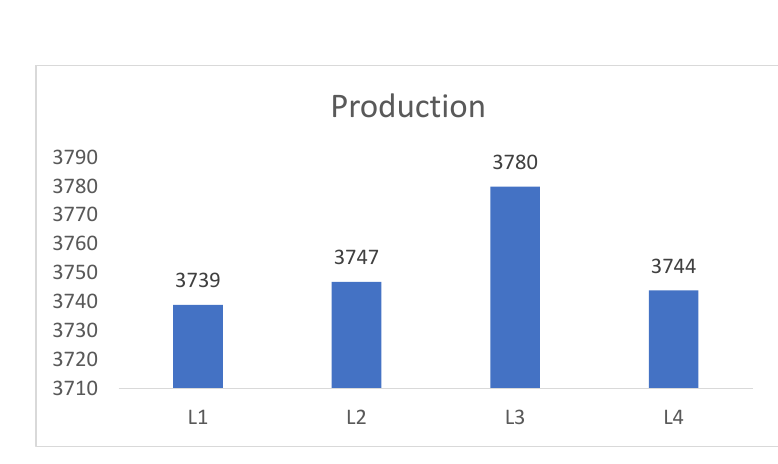
Figure 7. Volume of production.